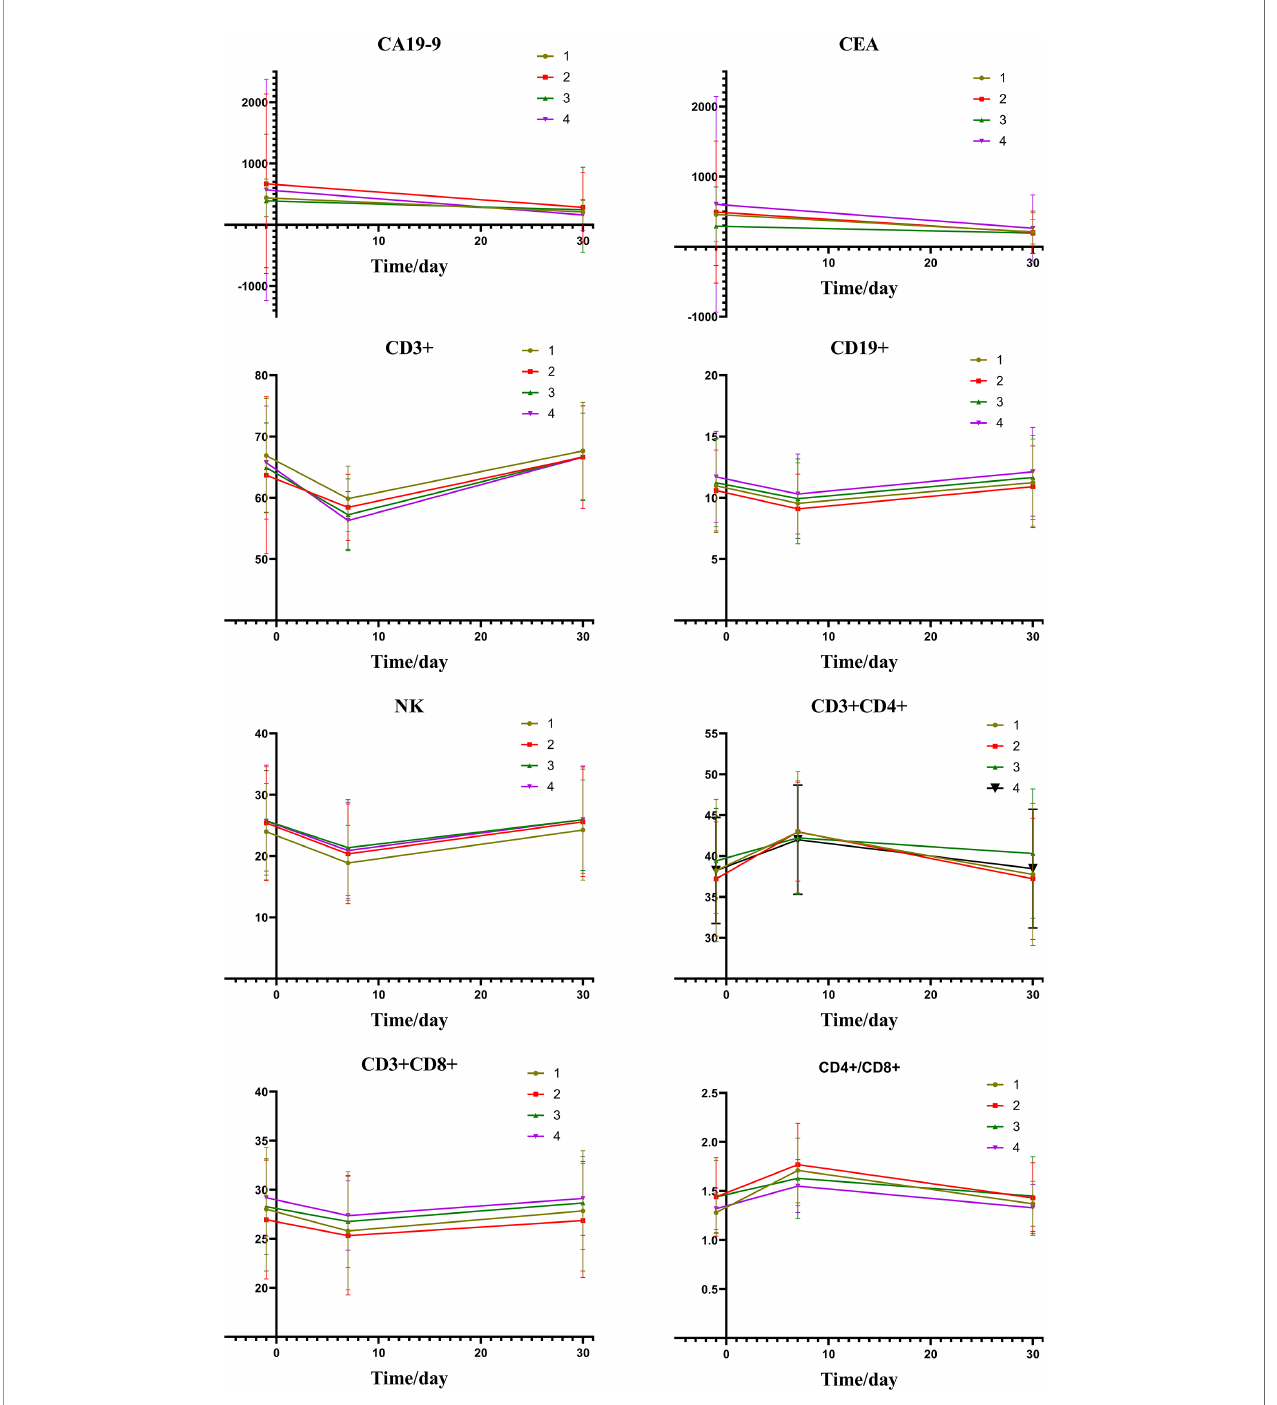
FIGURE 5 | Group1: low post-expression of HMGB1 with c-TACE; Group2: high post-expression of HMGB1 with c-TACE; Group3: low post-expression of HMGB1 with DEB-TACE; Group4: high post-expression of HMGB1 with DEB-TACE.